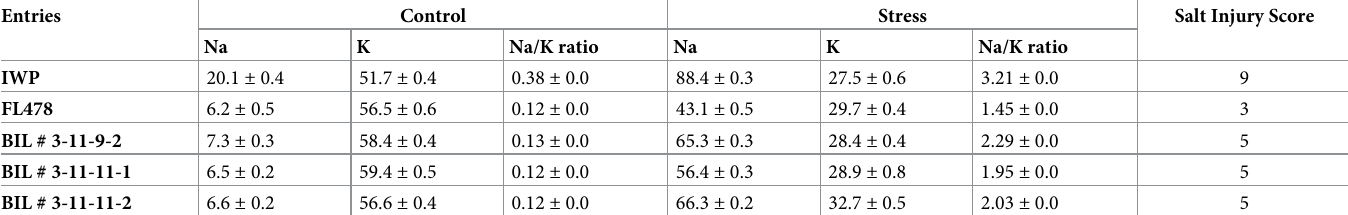
Table 6. Shoot Na + and K + concentration (mg/g) and Na + /K + ratios of BILs and parents under control and salt stress (100 mM) conditions using hydroponic solution. Entries